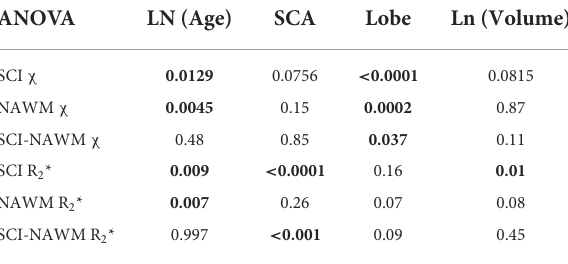
TABLE 2 Results of an ANOVA investigating the effect of subject age, sickle cell status, brain lobe and lesion volume on SCI and NAWM χ and R * 2 . ANOVA LN (Age)